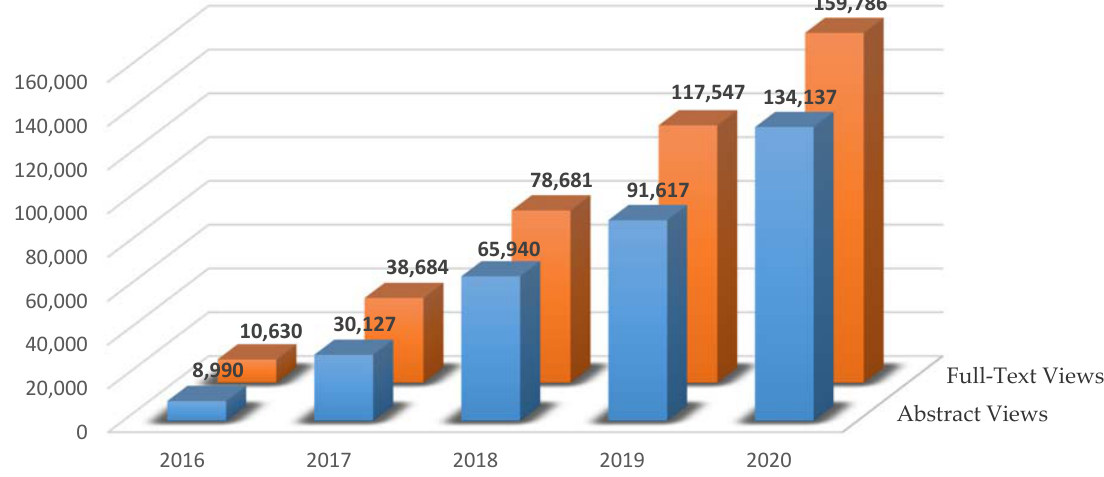
Figure 2. Total abstract and full-text views of IJNS publications in